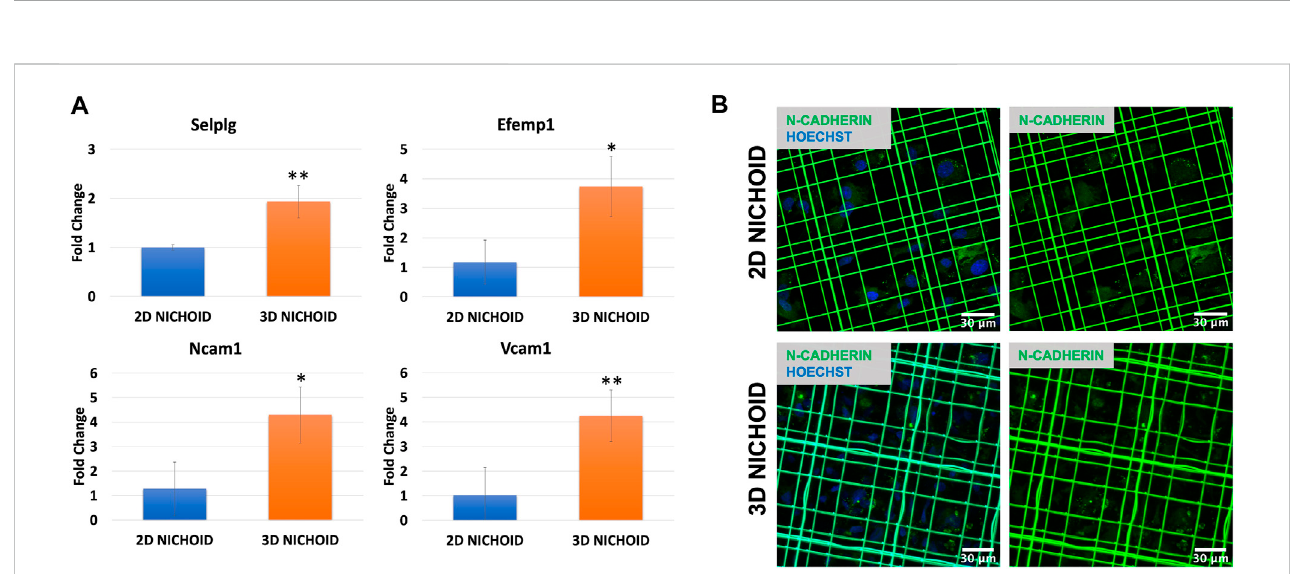
FIGURE 6 (A) Gene expression quanti fi cation through real-time PCR of Selplg ( n = 3), Efemp1 ( n = 4), Ncam1 ( n = 3), and Vcam1 ( n = 4) in rBMSCs grown in 3D and 2D Nichoids for 4 days. Gapdh was used as the housekeeping gene. Data are represented as mean ± SD; * indicates p value ≤ .05, and ** indicates p value ≤ .01 vs. 2D Nichoid. (B) Immuno fl uorescence images of nuclei (blue) and N-cadherin (green) in 3D and 2D Nichoids are shown. Scale bar = 30